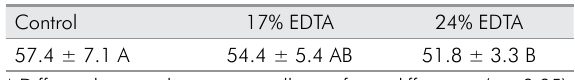
Table 4. Mean values and standard deviation of microhardness (Vickers) for self-adhesive resin cement Multilink ®